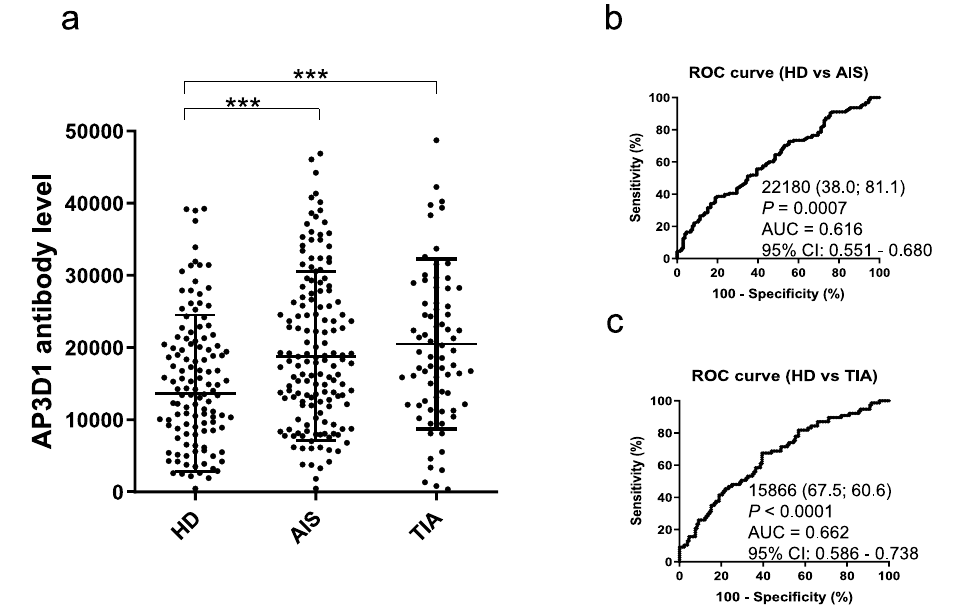
Figure 1. Comparing the serum AP3D1-antibody levels between healthy donors (HDs) and patients with AIS and TIA. This figure shows the levels of serum antibodies against AP3D1 (s-AP3D1-Abs) examined using amplified luminescence proximity homogeneous assay-linked immunosorbent assay (AlphaLISA) ( a ). The bars represent the average and average ± standard deviation (SD). P -values were calculated using the Kruskal–Wallis test (Mann–Whitney U test with Bonferroni’s correction applied). *** P < 0.001. The total average values, SDs, cutoff values, positive numbers, positive rates (%), and P -values are summarized in Table 1. A receiver operating characteristic (ROC) curve analysis was performed to assess the abilities of s-AP3D1-Abs in detecting either ( b ) acute ischemic stroke (AIS) or ( c ) transient ischemic attack (TIA). The numbers in the figures indicate the cutoff values for marker levels, and the numbers in parentheses indicate sensitivity (left) and specificity (right). P value, area under the curve (AUC), and 95% confidence intervals (95% CI) are also shown. AP3D1, adaptor- related protein complex 3 subunit delta 1. The results of the power calculation using G-Power 3.1 software were 0.9762618 for AIS and 0.9953412 for TIA (Supplementary Table